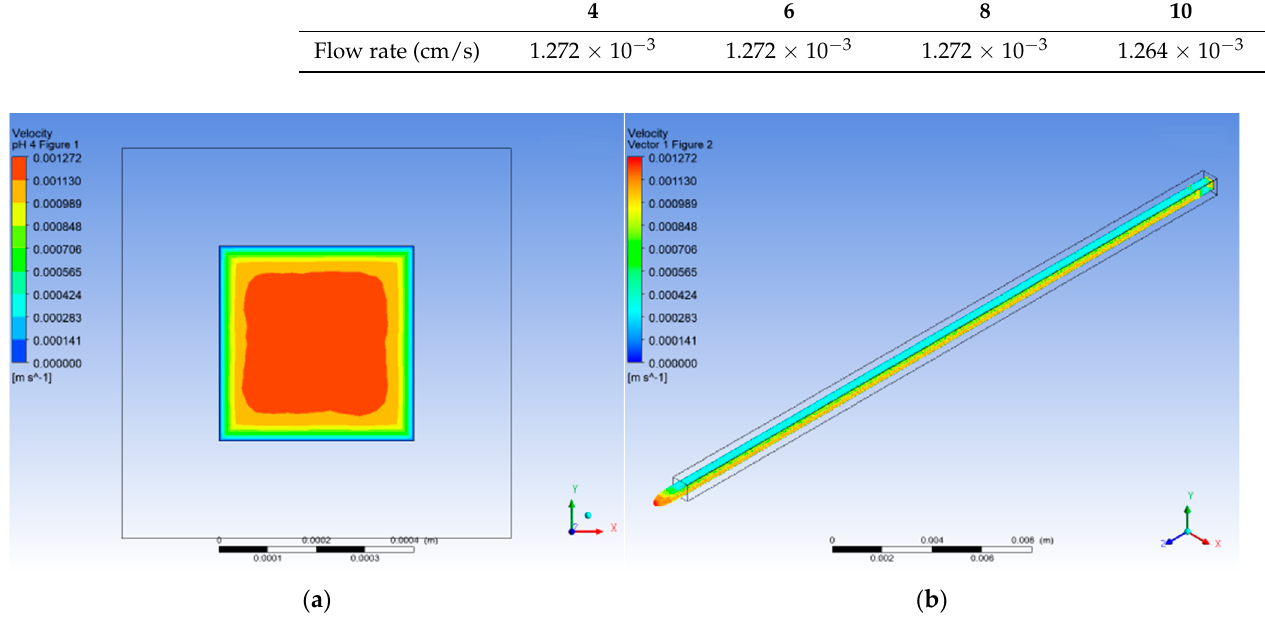
Figure 10. CFD numerical analysis results (pH 4): ( a ) contour; ( b ) vector.